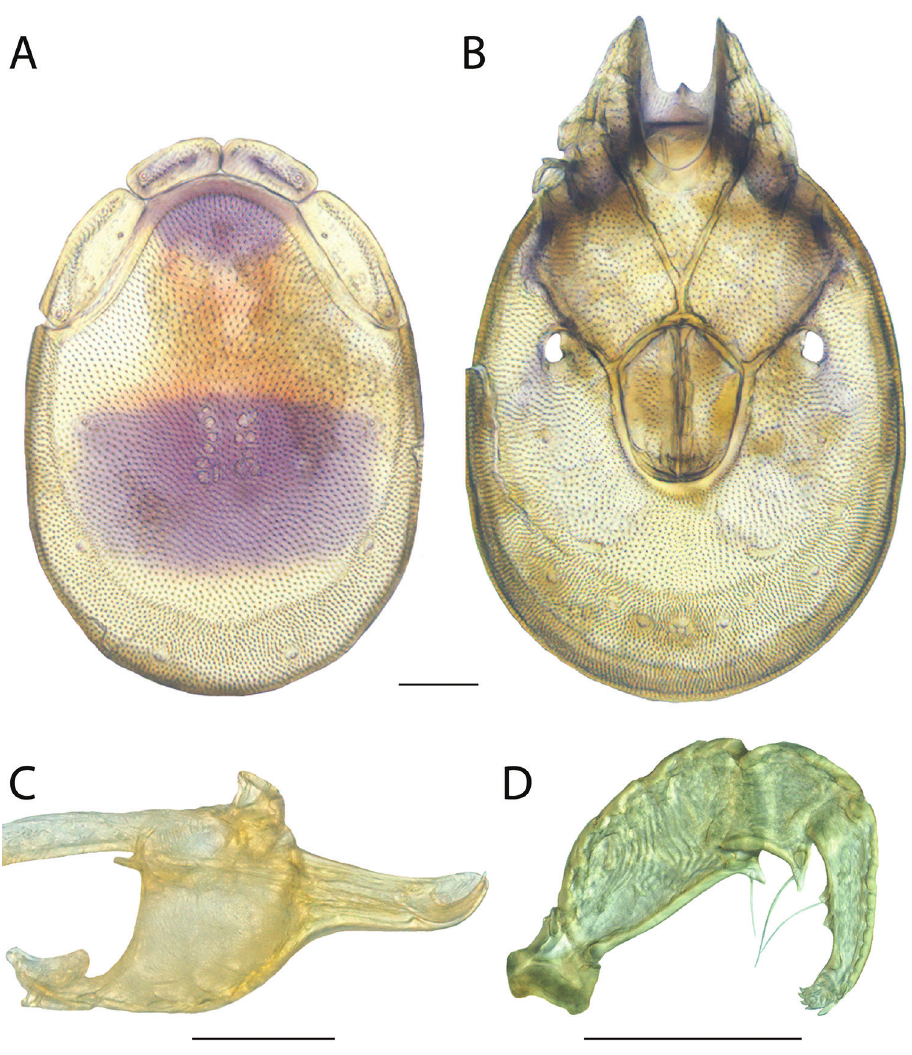
Figure 62. Torrenticola dunni sp. n. female: A dorsal plates B venter (legs removed) C subcapitulum D pedipalp (setae not accurately depicted). Scale = 100